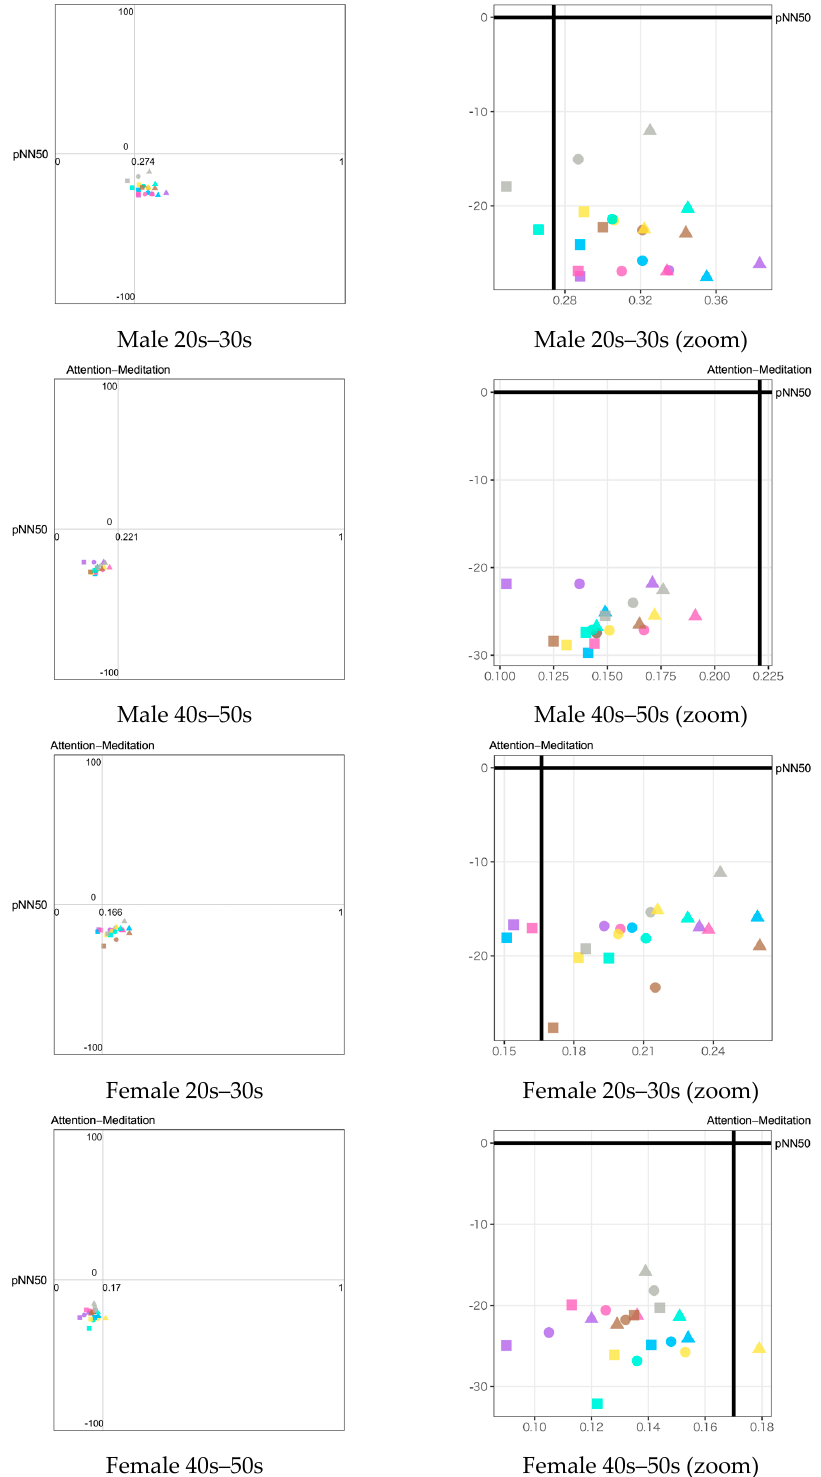
Figure 11. Emotion maps using pNN50 and Attention − Meditation divided by gender and generation. The left figures show the full-scale emotion maps. The right figures show the zoomed version of the emotion maps on the left for a closer observation of the plots. The dots with different colors indicate the different olfactory stimuli as shown in the legend (Figure